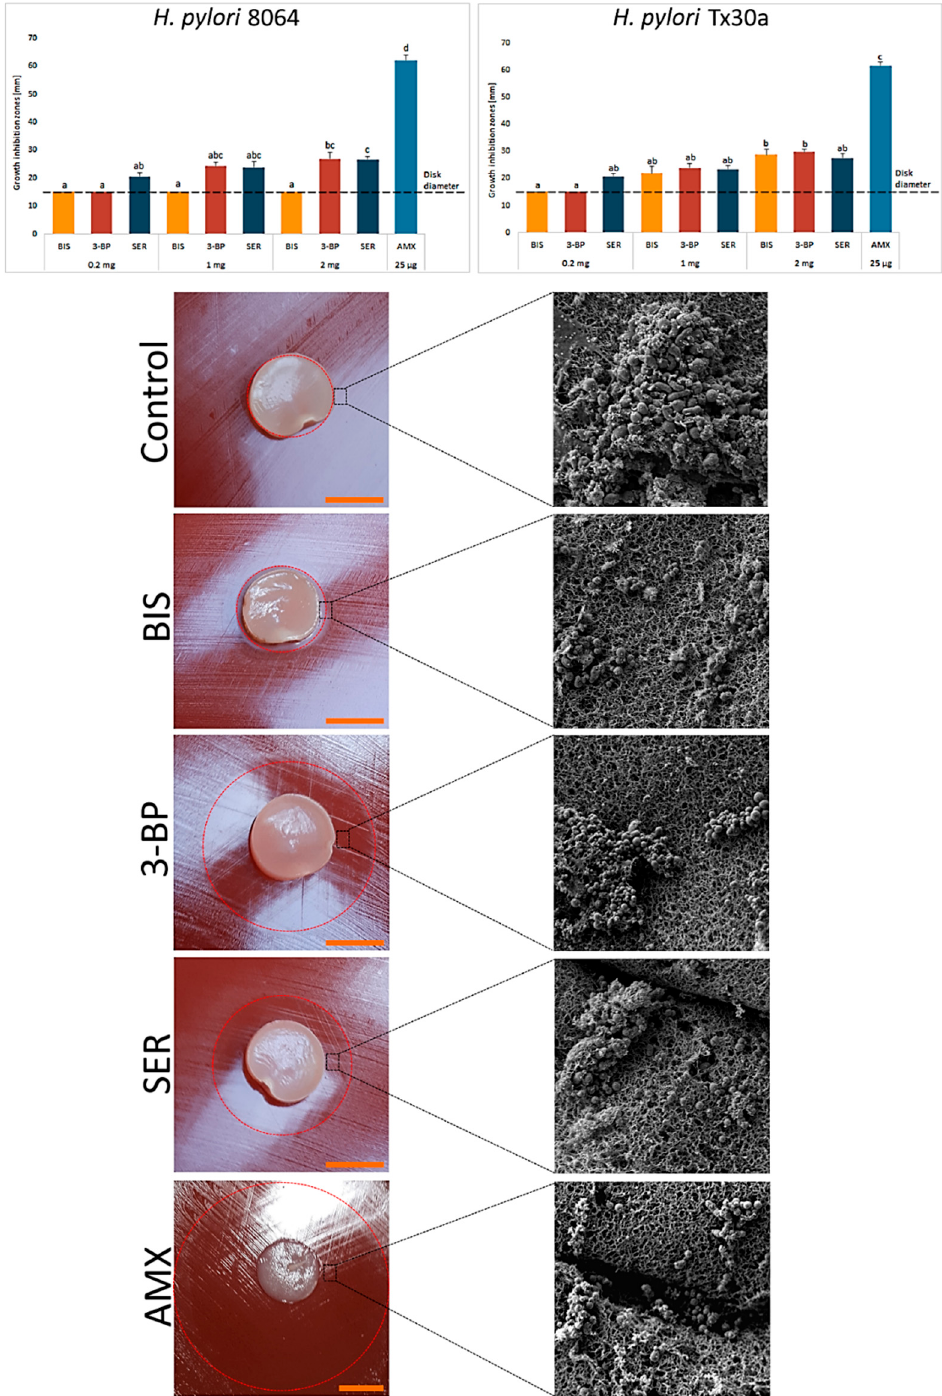
Figure 3. Activity of bismuth subsalicylate (BIS), 3-bromopyruvate (3-BP), sertraline (SER), and amoxicillin (AMX) released from BC carriers against H. pylori 8064 and Tx30a strains measured by a modified disk-diffusion method. Asterisks stand for a statistical significance (K-W test with post-hoc Dunn’s analysis). The dot-line at the value of 15 mm represents the diameter of BC carrier. Representative photos of H. pylori 8064 growth inhibition zones and cell morphology after exposure to BC carriers not chemisorbed (a negative control) or the tested compounds. Columns with the same subscript letters (a, b, c) are not significantly different from each other ( p > 0.05). The presented results are the average of three independent biological tests ( n = 3). Scale bar is equal to 1 cm.